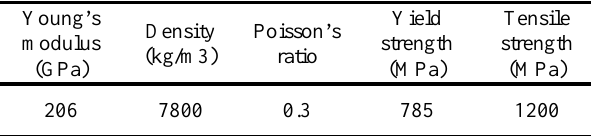
Table 1. material properties of 65Mn